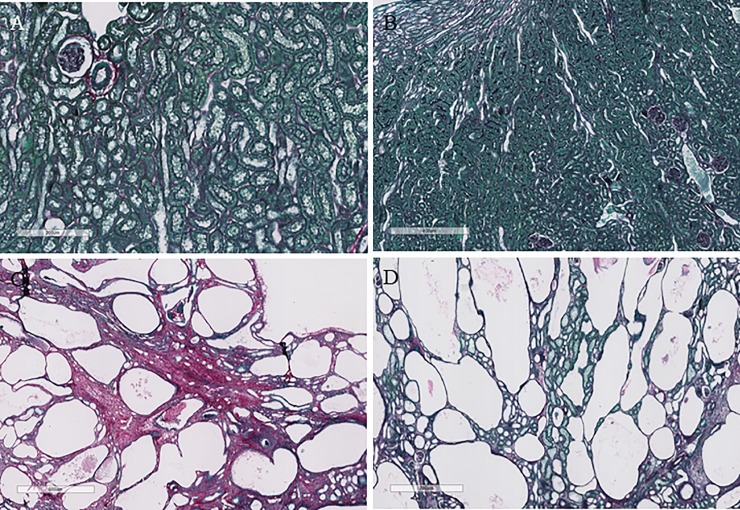
Representative photomicrographs of Sirius red stained sections of kidney tissue showing interstitial collagen deposition at week 20 in Lewis+NWI (A), Lewis+HWI (B), LPK+NWI (C) and LPK+HWI (D). There was no change in renal fibrosis in the Lewis rats with increased water intake, whereas in LPK rats (D) there was a marked attenuation in interstitial collagen deposition in comparison to LPK+NWI (C).